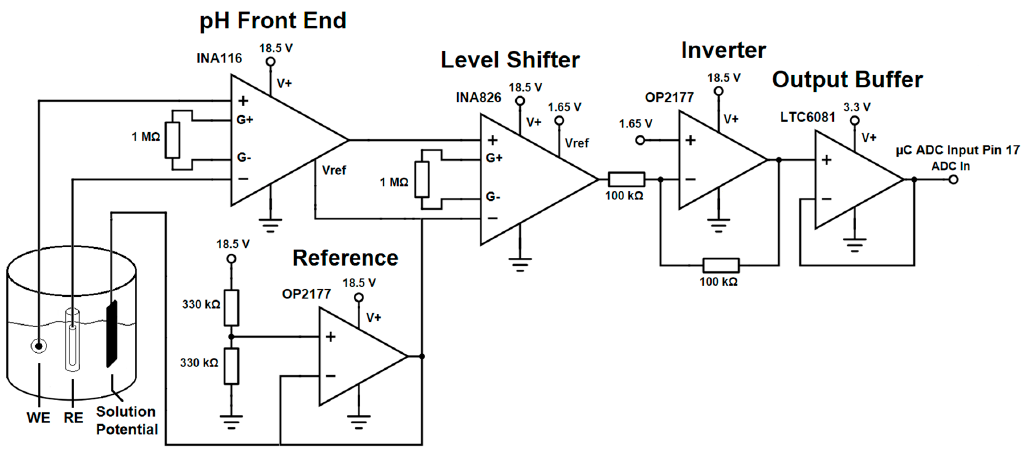
Figure 3. Schematic of the basic functional circuit of the developed pH readout system. WE: working electrode, RE: reference electrode.